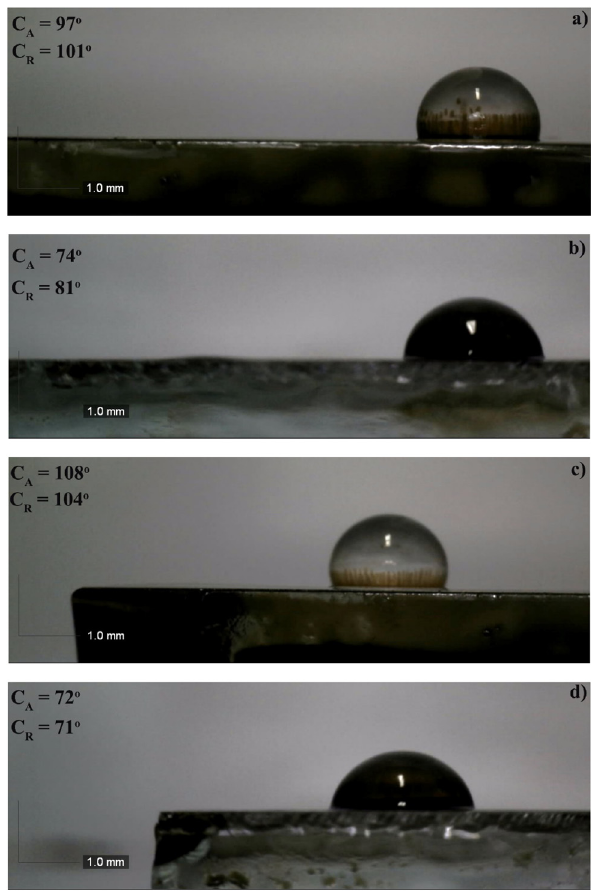
Figure 10: Comparison of advancing and receding contact angles of ( a ) oil - wet surface ( fi rst point ) , ( b ) surface treated with the polymer nanohybrid ( third point ) , ( c ) oil - wet surface ( fi rst point ) , ( d ) surface treated with the polymer nanohybrid ( third point )